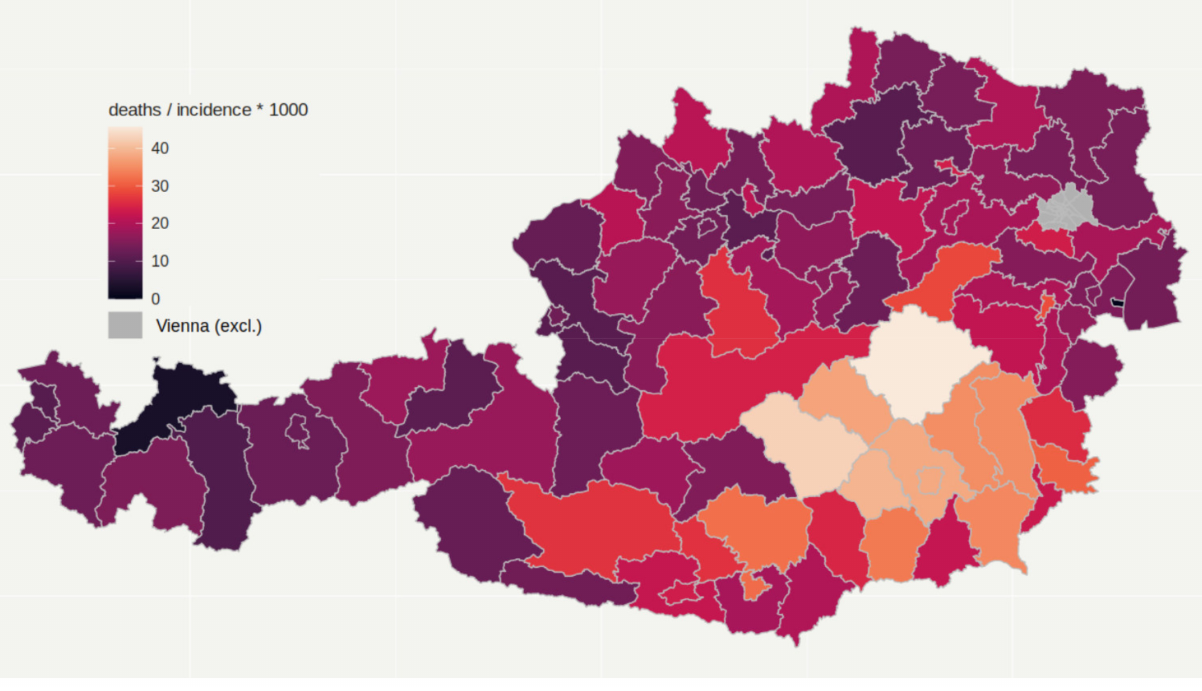
Figure 3. Deaths per incidence in Austrian districts until 10 February